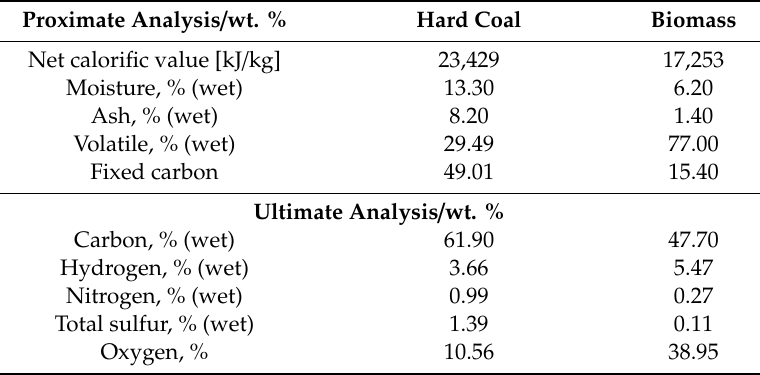
Table 1. Proximate and ultimate analysis of hard coal and biomass. Proximate Analysis/wt. %